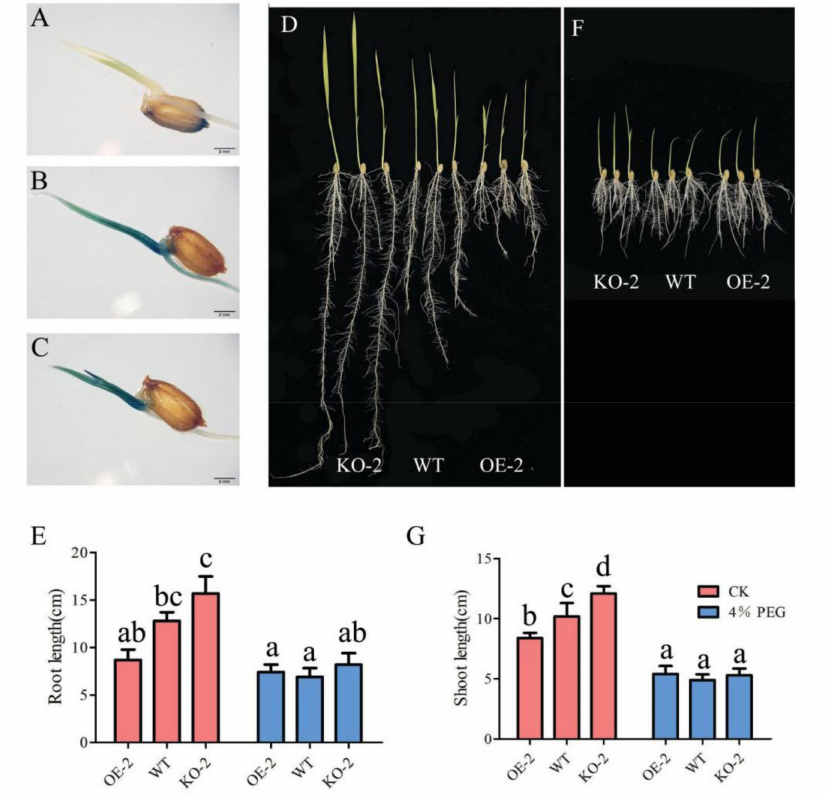
Figure 4. OsGA2ox8 was differentially expressed in shoots and roots under osmotic stress. ( A – C ) His- tochemical assay of GUS activity driven by the OsGA2ox8 promoter (2193 bp) under the non-stress condition ( B ) and osmotic stress ( C ), as well as the wild-type plants ( A ). ( D – G ) Shoot and root length of transgenic lines and the wild type at 10 days after germination under the non-stress condition ( D , E ) and osmotic stress ( F , G ). Different letters in ( E ) and ( G ) indicate significant differences ( p < 0.05, one-way ANOVA followed by Tukey’s HSD test) based on data for three